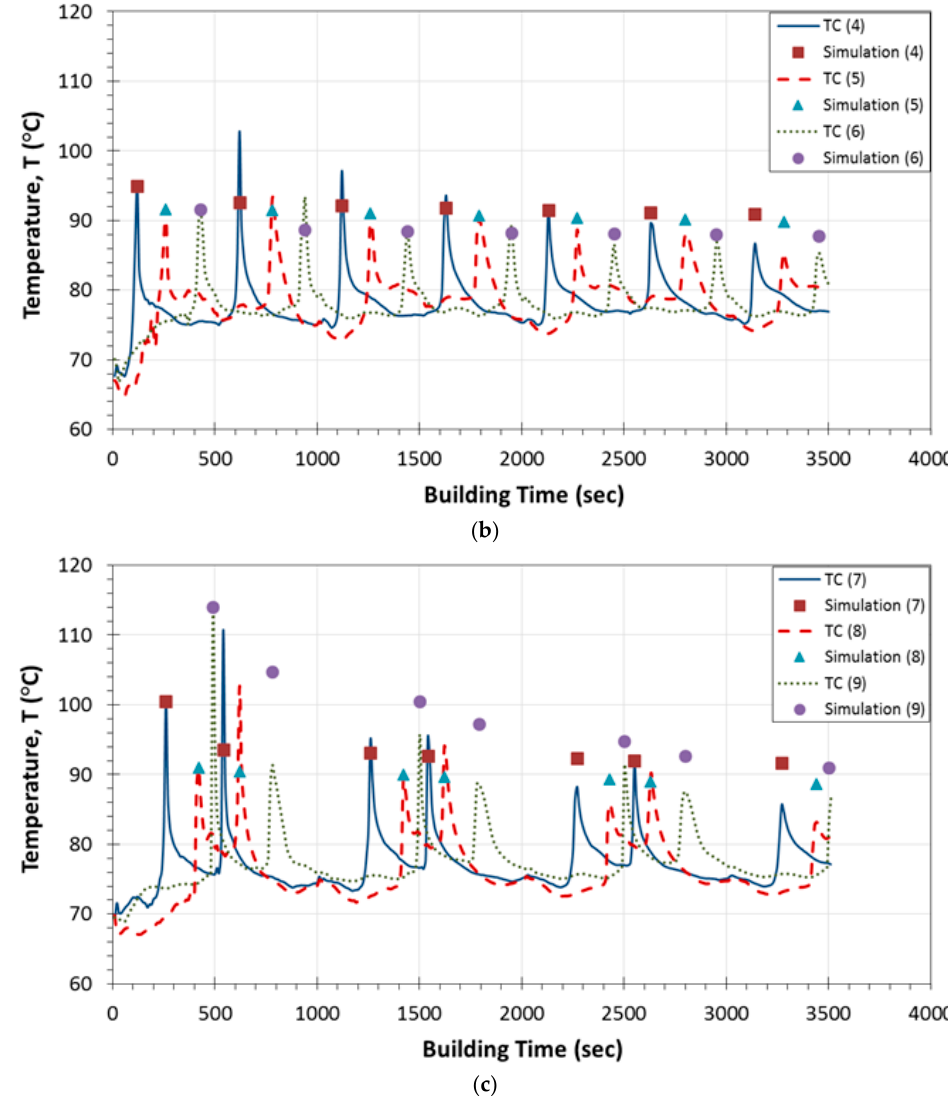
Figure 3. Temperature profiles as recorded by thermocouples in addition to temperature peak values as calculated by FEA for embedding locations: ( a ) 1, 2 and 3; ( b ) 4, 5 and 6; ( c ) 7, 8 and 9. A comparison between temperature values as measured in real-time throughout the 10th layer’s surface by the thermocouple sensors and as calculated by the finite element model is schematically presented in Figure 4, for the better understanding of the resulted deviations. In general, a good agreement is demonstrated between the experimentally obtained and the numerically calculated temperatures at almost all the embedding locations except for positions 3 and 9. Small differences of 0.4 °C to 1.5 °C can be considered as negligible since they fall within the inherent sensitivity range of the recording sensors.